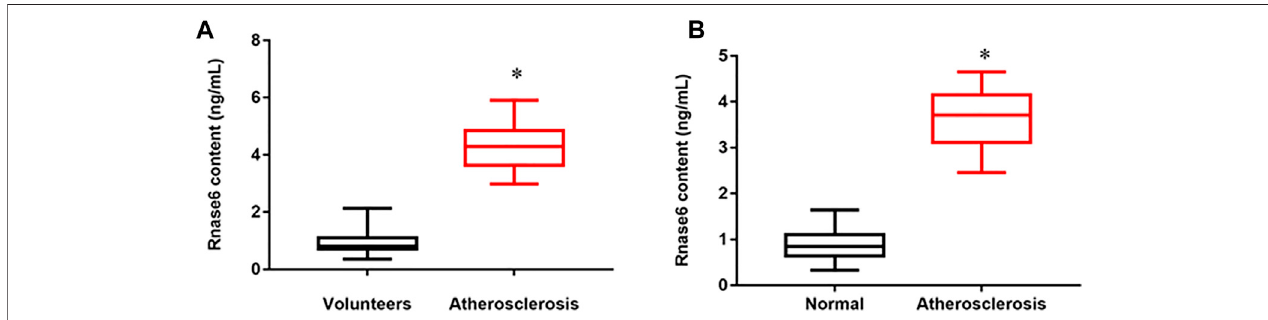
FIGURE 1 | Upregulated expression of Rnase6 in peripheral blood and plaque tissue of atherosclerotic patients. (A) . Peripheral blood was collected from healthy volunteers and patients with atherosclerosis (N (cid:2) 50, 25 volunteers and 25 patients). The secretion level of Rnase6 was detected by ELISA. (B) . The expression of Rnase6 in normal arterial wall and atherosclerotic tissue plaques were analyzed by ELISA. N (cid:2) 6, * p < 0.01.